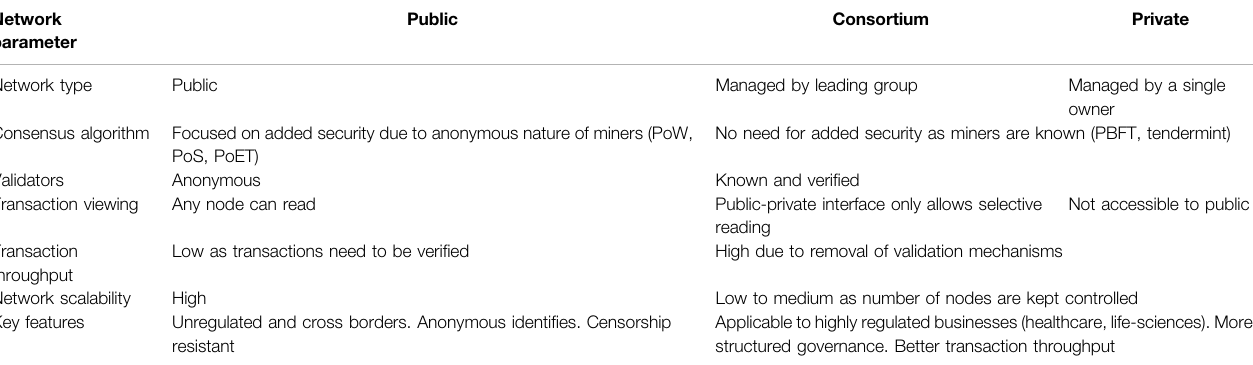
TABLE 2 | Differences in network parameters across blockchain